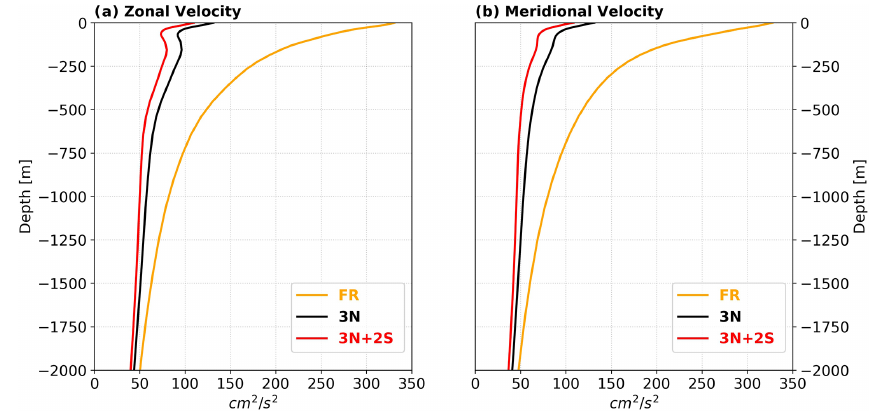
Figure 14. Global averaged error variance (in cm 2 s − 2 ): (a) zonal velocity and (b) meridional velocity over the period of March to December 2015. The results were obtained by comparing the zonal and meridional velocities of OSSEs with the NR; FR (orange lines), OSSE1 (3N; black lines) and OSSE2 (3N + 2S; red lines).